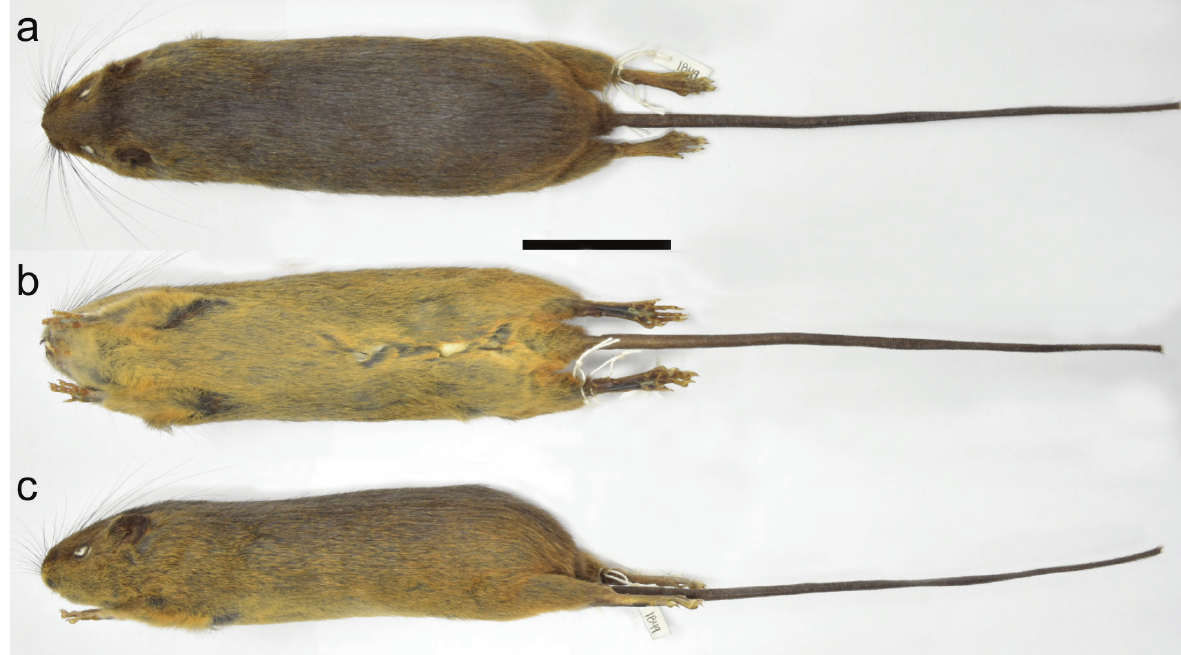
Figure 7. Mindomys kutuku sp. nov. (MECN 5809, holotype; Cordillera de Kutukú, Ecuador): external aspect based on museum skin in dorsal ( a ), ventral ( b ), and lateral ( c ) view. Scale bar: 50 mm.